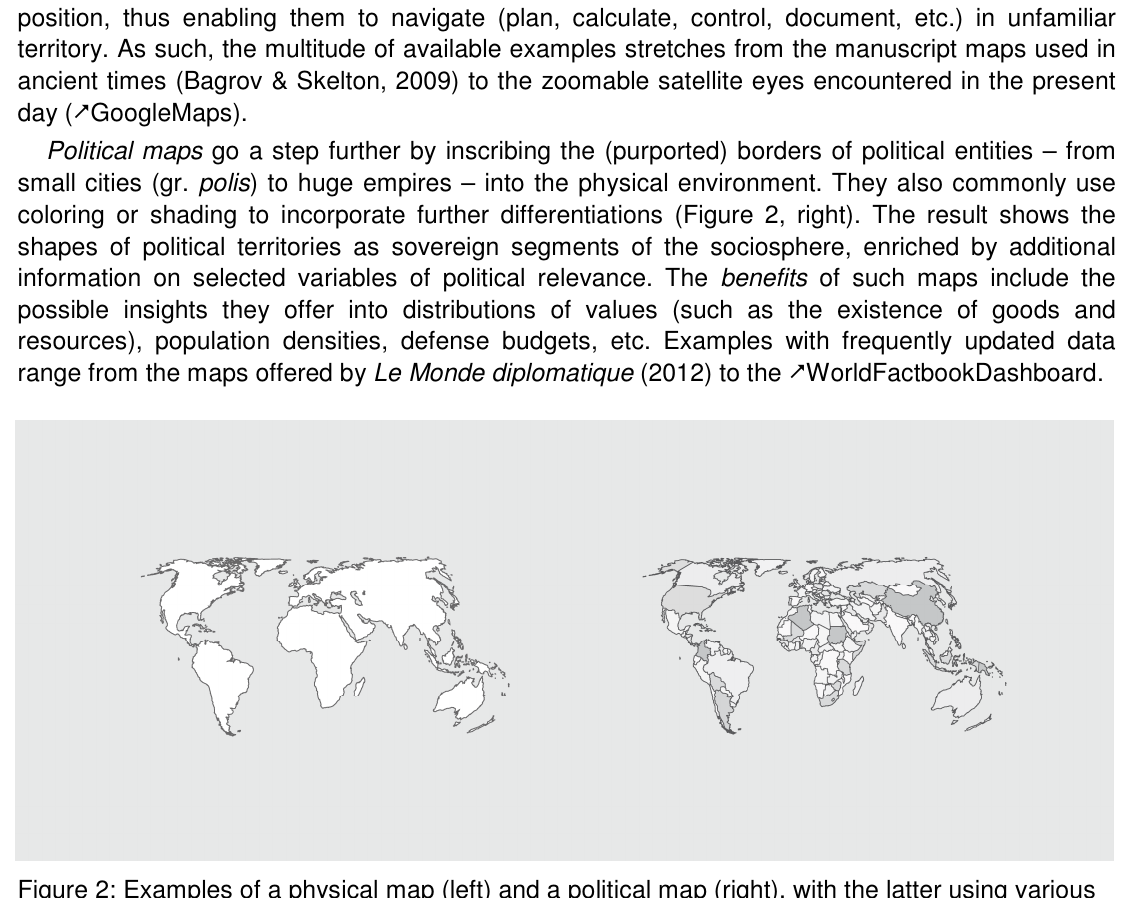
Figure 2: Examples of a physical map (left) and a political map (right), with the latter using various colors to visualize the extensions and possible attributes of political